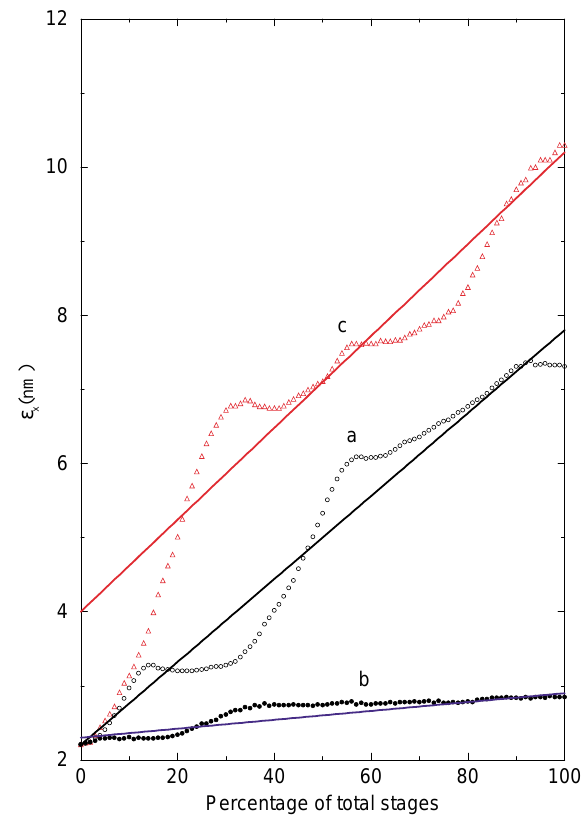
FIG. 5. (Color) The interim emittance degradation behavior as the beam particles traverse through the system of a chip model for s D (cid:1) 0.1 m m. For each case, a solid line of a linear behav- ior is included to guide the eye. Curve a , total stages 50 K, c s (cid:1) 0.15 rad. Curve b , total stages 50 K, c s (cid:1) 0.05 rad. Curve c , total stages 20 K, c s (cid:1) 0.15 rad. mean linear behavior is observed for curves ( a ) and ( b